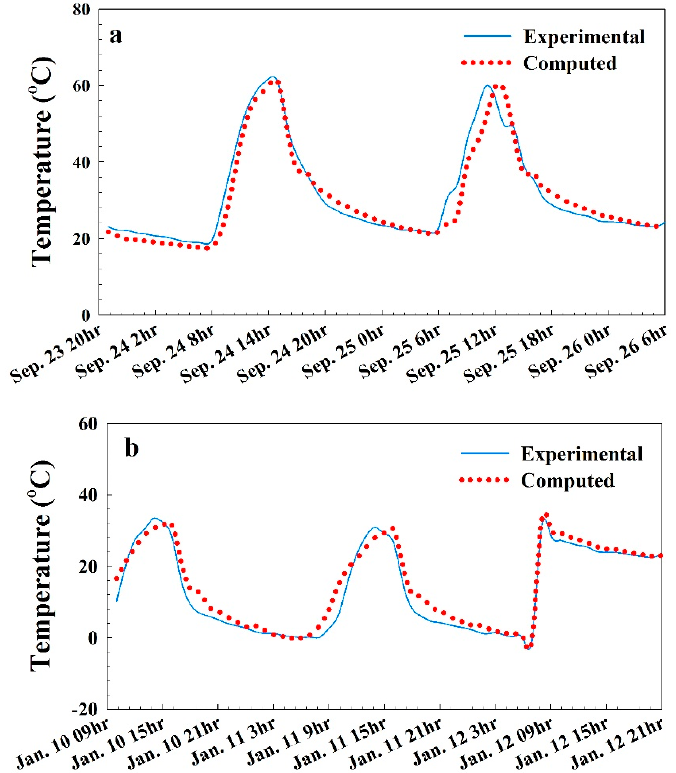
Figure 9. Computed vs. measured internal air temperatures of a ( a ) fully closed greenhouse, and ( b ) naturally ventilated greenhouse.